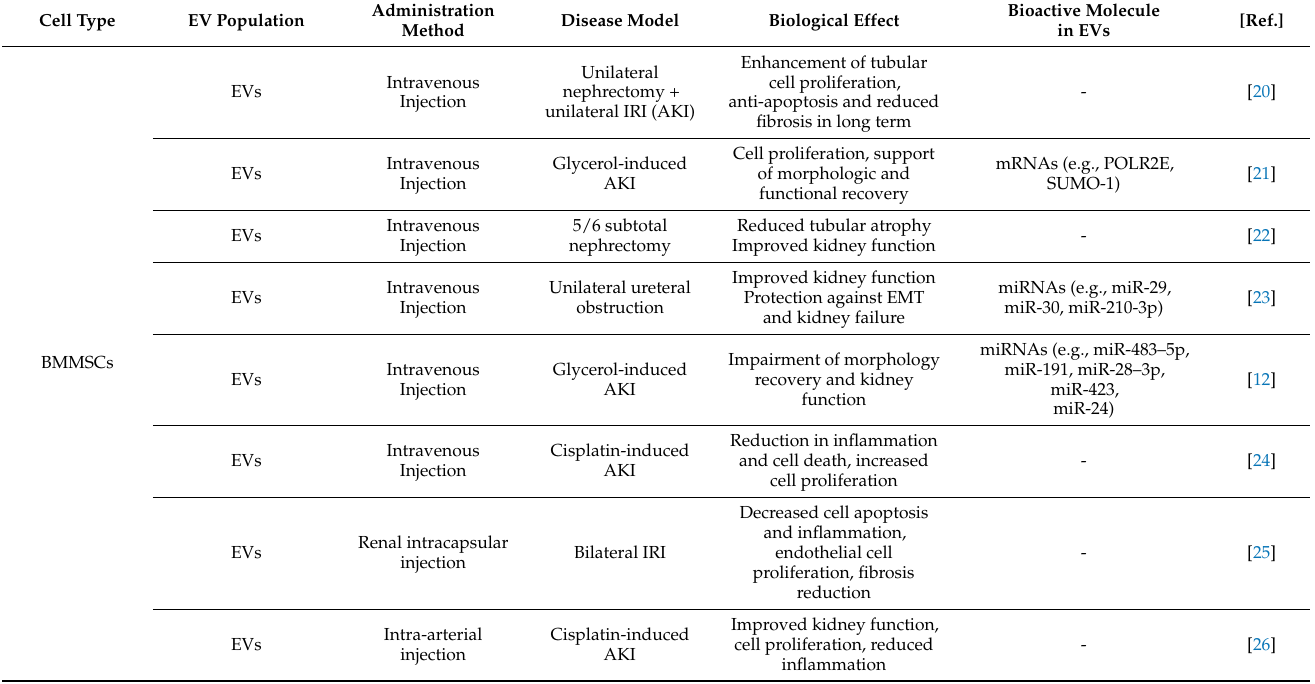
Table 1. Therapeutic effects of EVs derived from different cell